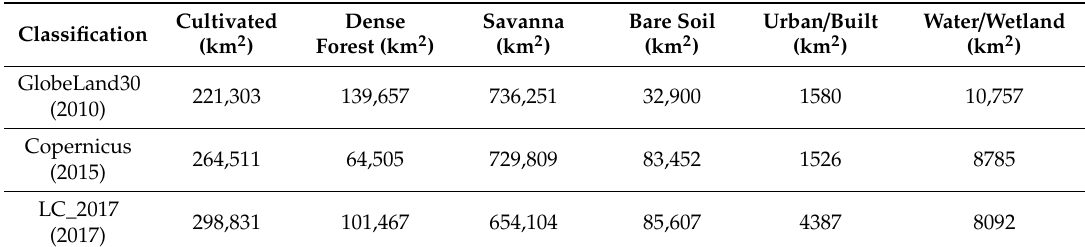
Table 4. Land-cover area, from the three di ff erent land-cover products: GlobeLand30 for 2010 at 30 m resolution, Copernicus 2015 Land-Cover Product at 100 m resolution (resampled to 30 m), and LC_2017 product for 2017 at 30 m